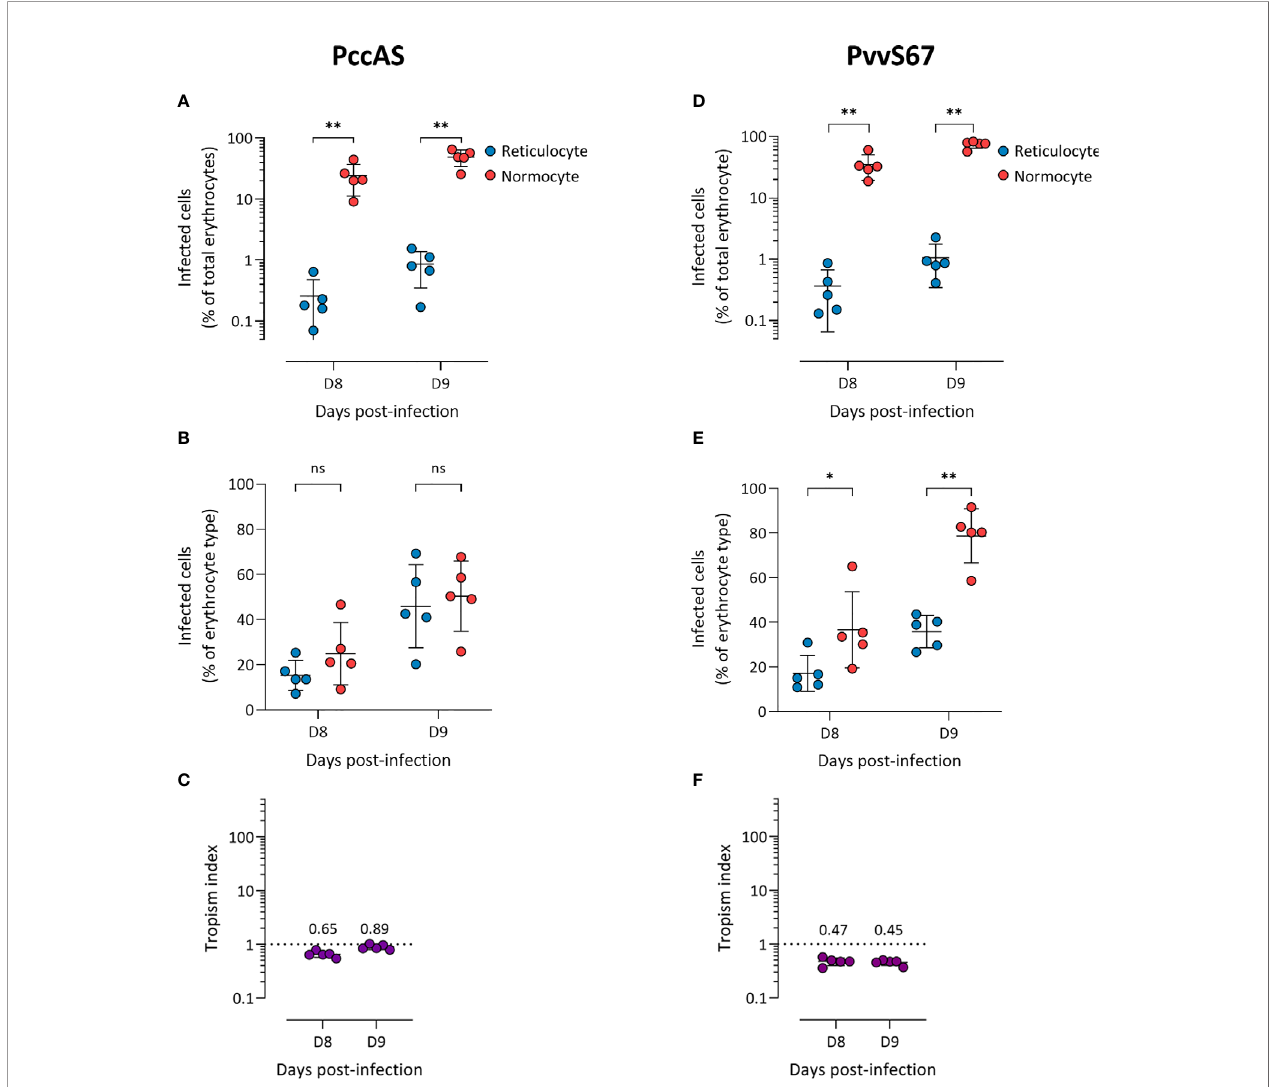
FIGURE 2 | P. chabaudi chabaudi AS has no erythrocyte preference (A – C) and P. vinckei vinckei S67 prefers normocytes (D – F) in vivo . Flow cytometry data of peripheral blood taken from infected mice before the peak of infection (two days shown). Reticulocytes (blue circles) and normocytes (red circles) are de fi ned as CD71+ CD98+ cells and CD71- CD98- cells, respectively. Infected cells are Hoechst-positive. (A, D) Data shown are infected reticulocytes and infected normocytes, as a percentage of total erythrocytes. (B, E) Data normalized to the relative frequencies of reticulocytes and normocytes, by expressing infected reticulocytes and normocytes as a percentage of total reticulocytes and total normocytes, respectively. (C, F) The in vivo tropism index is calculated as the ratio of percentage of infected reticulocytes (out of total reticulocytes) to percentage of infected normocytes (out of total normocytes). The mean tropism indices ( n = 5 mice) are shown. Dotted lines at tropism index = 1 represent no erythrocyte preference. All error bars are standard deviations. ns, not signi fi cant; * p < 0.05; ** p <